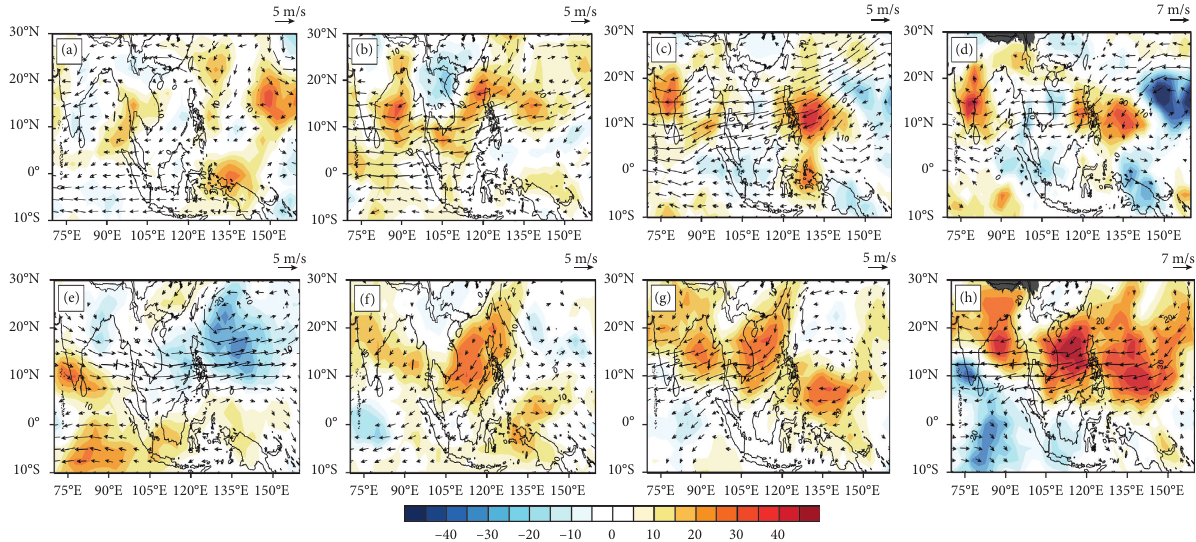
Figure 8: Composite differences in OLR (W/m 2 , shadings) and 850 hPa wind (m/s, vectors) based on th SCSSM withdrawal date in typical years of the epoch 1979–1993: (a) one pentad before the monsoon onset ( P − 1), (b) during the monsoon onset (P0), (c) one pentad after the monsoon onset ( P + 1) and the withdrawal stages (pentads 53 − 37), and (d) differences between after ( P + 1) and before ( P − 1) the monsoon withdrawal. (e–h) the same as (a–d) but for the epoch